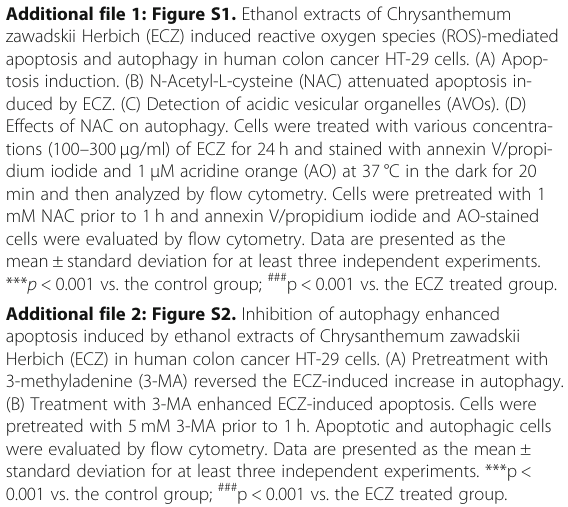
Additional file 2: Figure S2. Inhibition of autophagy enhanced apoptosis induced by ethanol extracts of Chrysanthemum zawadskii Herbich (ECZ) in human colon cancer HT-29 cells. (A) Pretreatment with 3-methyladenine (3-MA) reversed the ECZ-induced increase in autophagy. (B) Treatment with 3-MA enhanced ECZ-induced apoptosis. Cells were pretreated with 5 mM 3-MA prior to 1 h. Apoptotic and autophagic cells were evaluated by flow cytometry. Data are presented as the mean ± standard deviation for at least three independent experiments. ***p < 0.001 vs. the control group; ### p< 0.001 vs. the ECZ treated